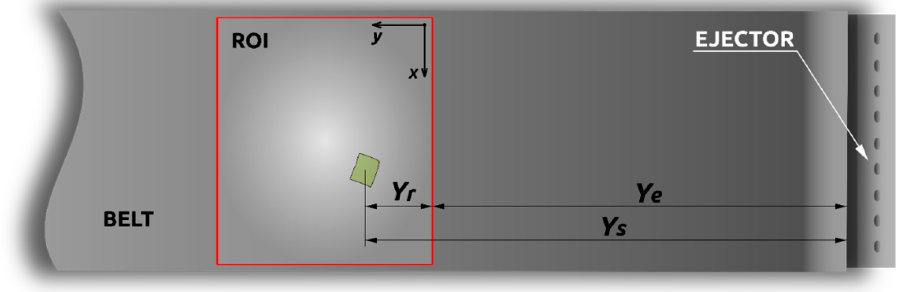
Figure 4. The process of determining which pneumatic valve to open and when to eject the granule.